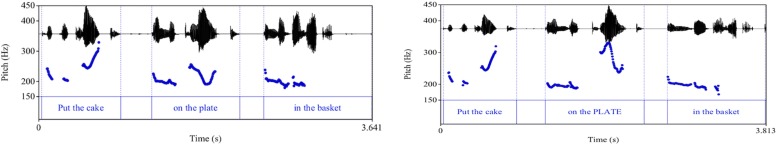
Waveform, pitch track, and accent type of sentence with H∗
(left) and L + H∗
(right).